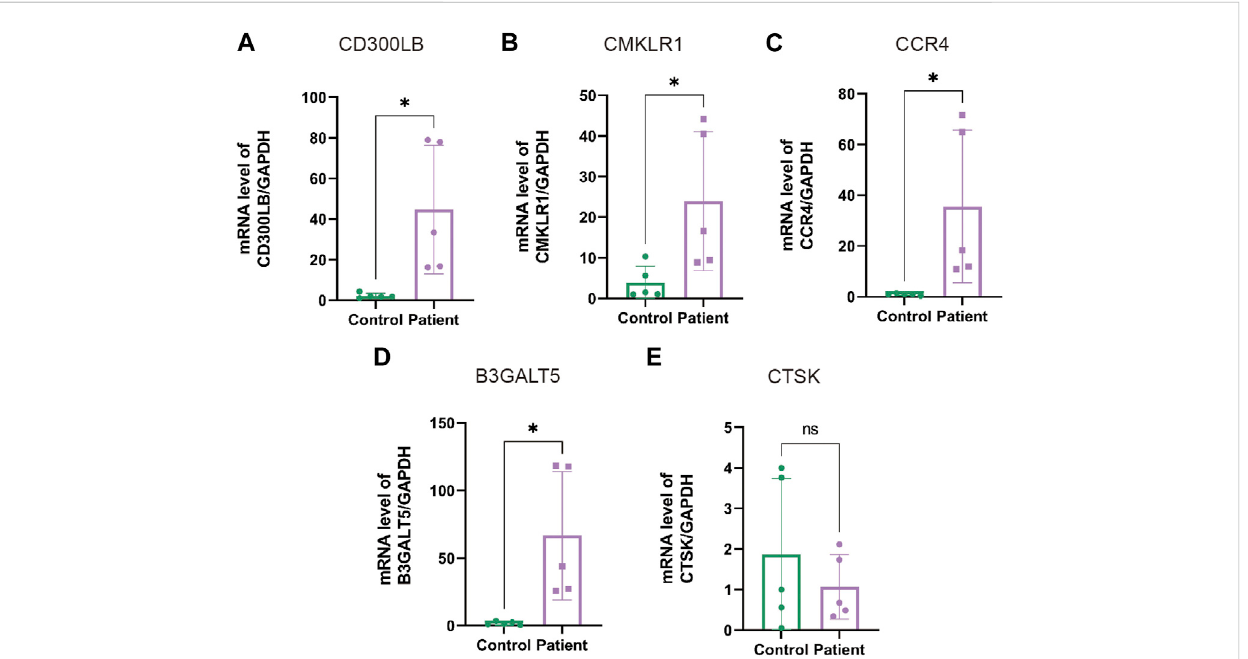
The mRNA levels of hub genes in sperm specimens measured by qRT-PCR. The mRNA levels of CD300LB (A) , CMKLR1 (B) , CCR4 (C) , B3GALT5 (D) , and CTSK (E) in the patients with AZS and CE, as well as healthy controls, with GAPDH serving as the standard control. * indicates p < 0.05.